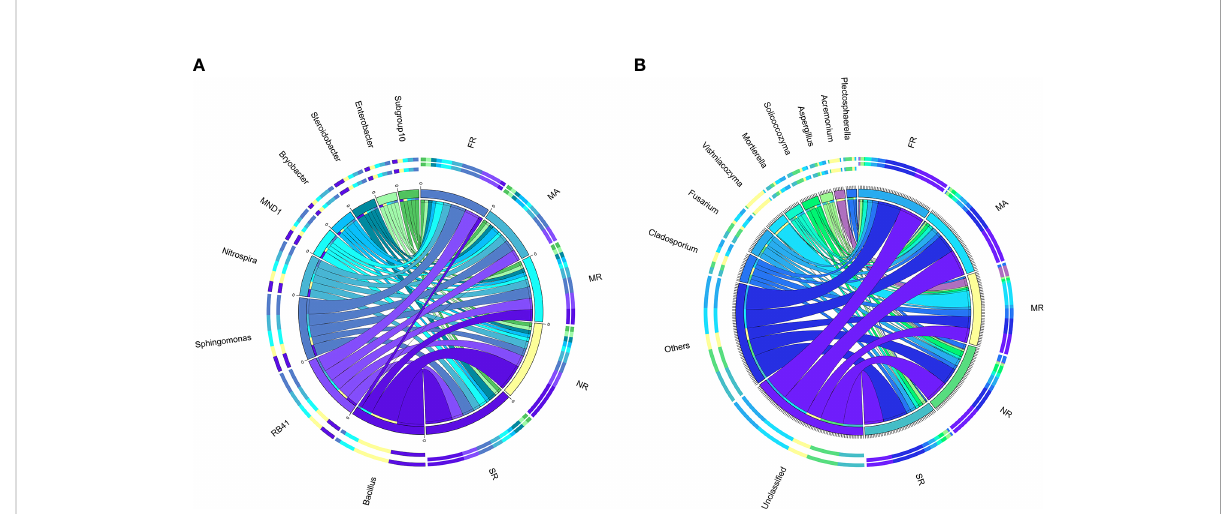
FIGURE 4 Distribution of dominant genera (top 10) in fi ve different samples. (A) represents the bacterial community in the soil of the rhizosphere. (B) represented the fungal community in rhizosphere soil) The thickness of each ribbon represents the abundance of each taxon. The relative tick above the outer segment stands for the relative abundance of each taxon. Data were visualized using Circos (version 0.69,